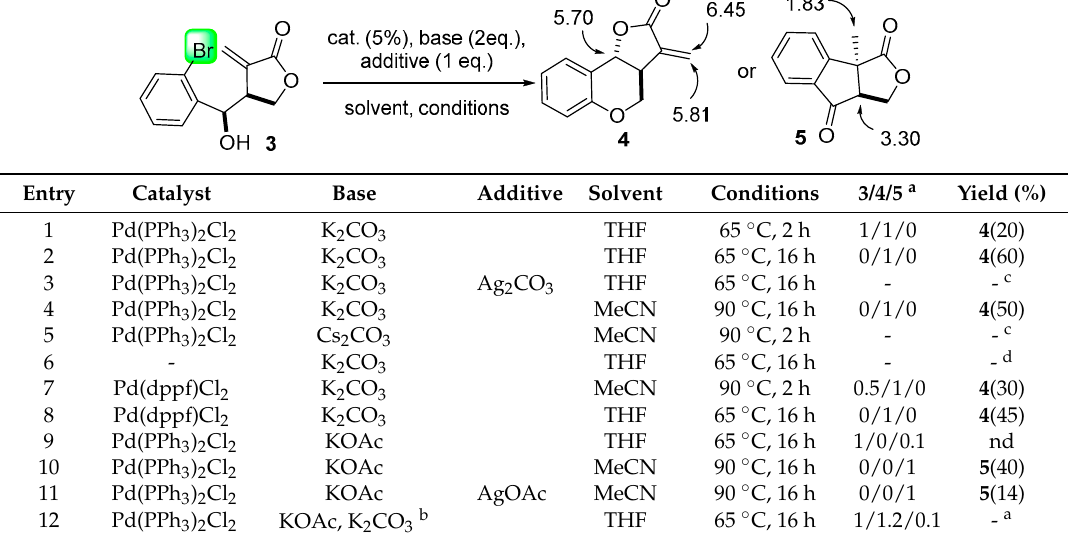
Table 1. Selective access to lactones 4 and 5